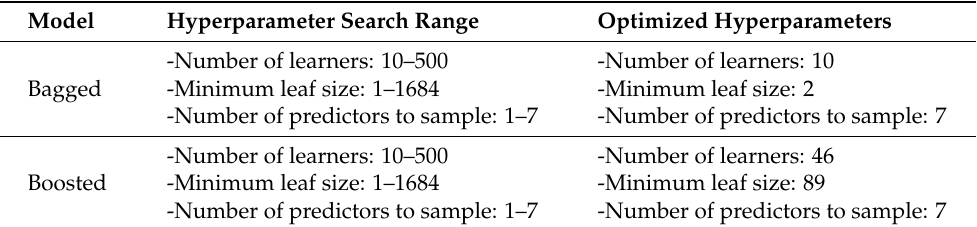
Table 5. The optimum hyperparameters using Bayesian hyperparameter optimization.